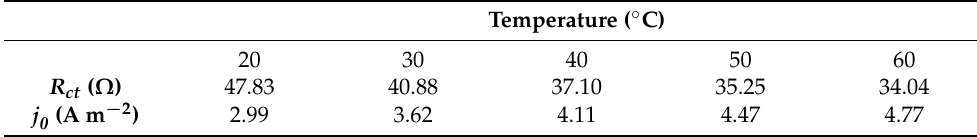
Table 1. Charge transfer resistance and reference exchange current density for LFP at different